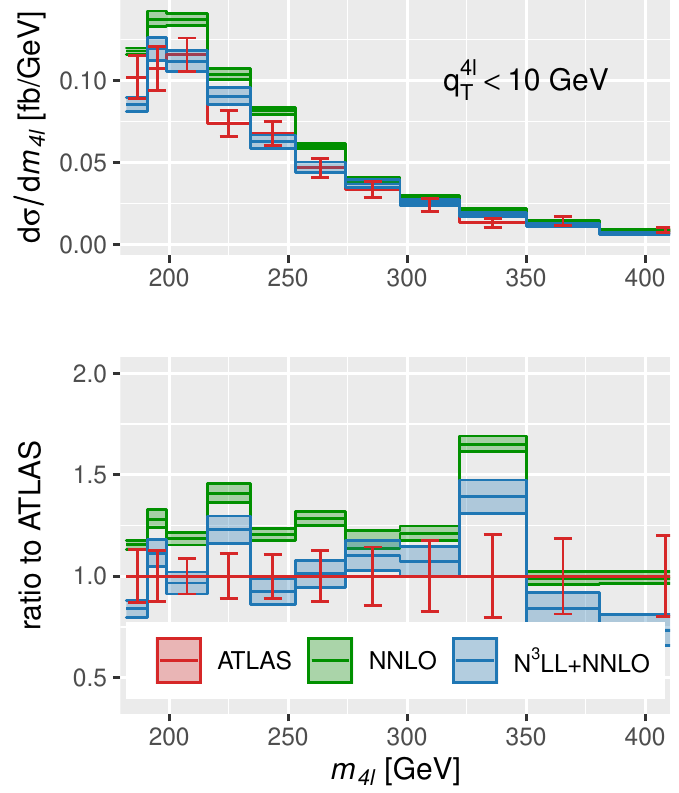
< 10 GeV at NNLO and N 3 LL+NNLO compared with T